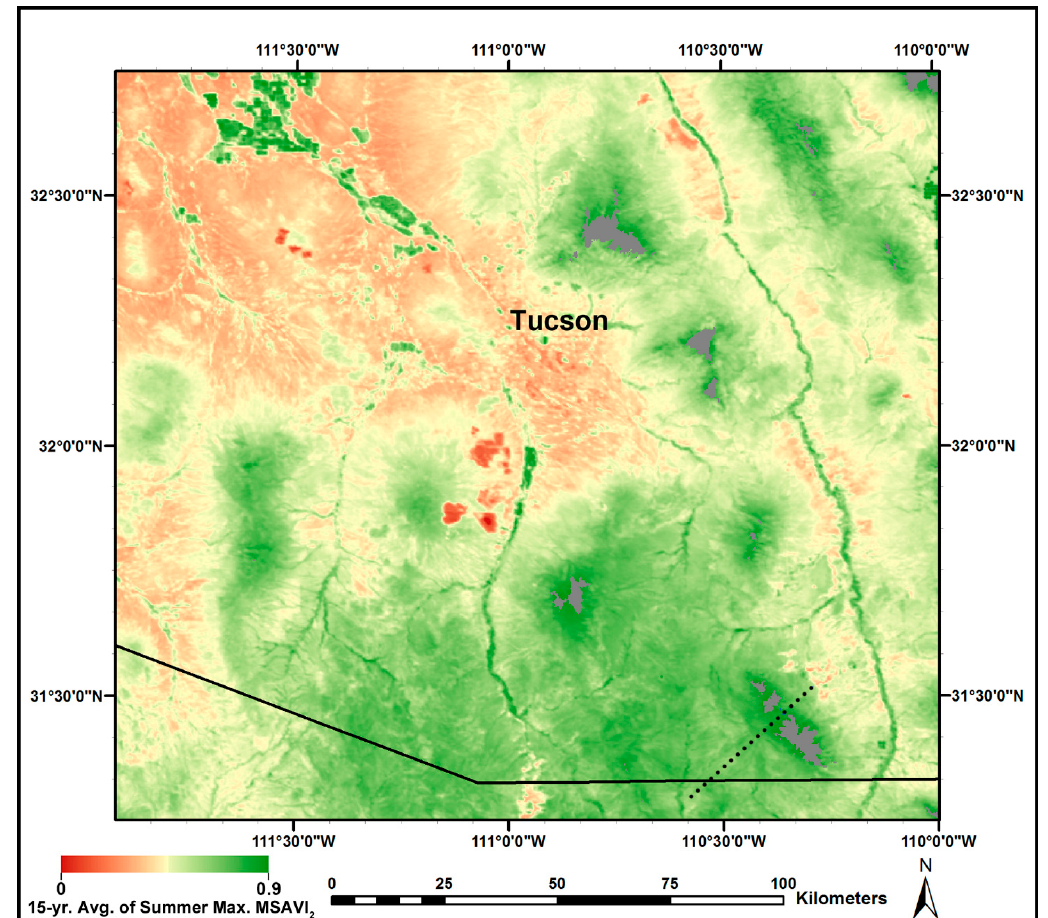
Figure 10. Image-based map of the 15-year (2000–2014) average of the maximum MSAVI 2 from MODIS (tile h08v05) within the summer period. Gray color indicates the data mask applied to cloud- and snow-prone areas (elevation > 2134 m). The diagonal, broken line is the transect across the Huachuca Mountains from which the image data were sampled for comparative analysis.